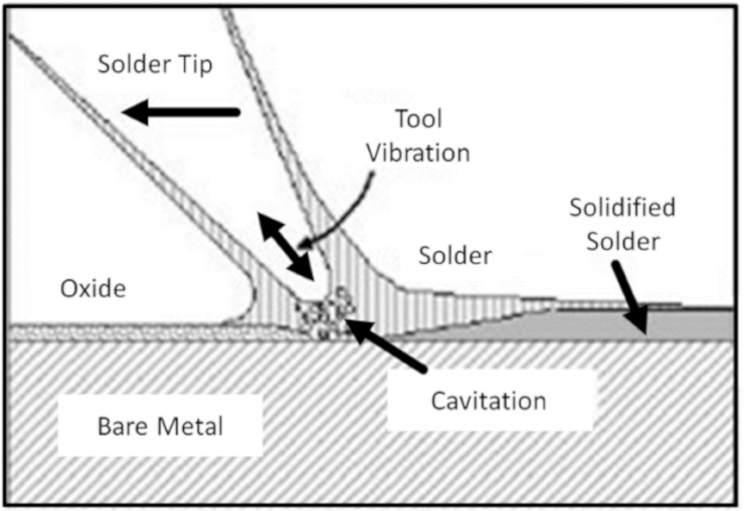
Figure 1. Schematic illustration of the cavitation mechanism in ultrasonic soldering